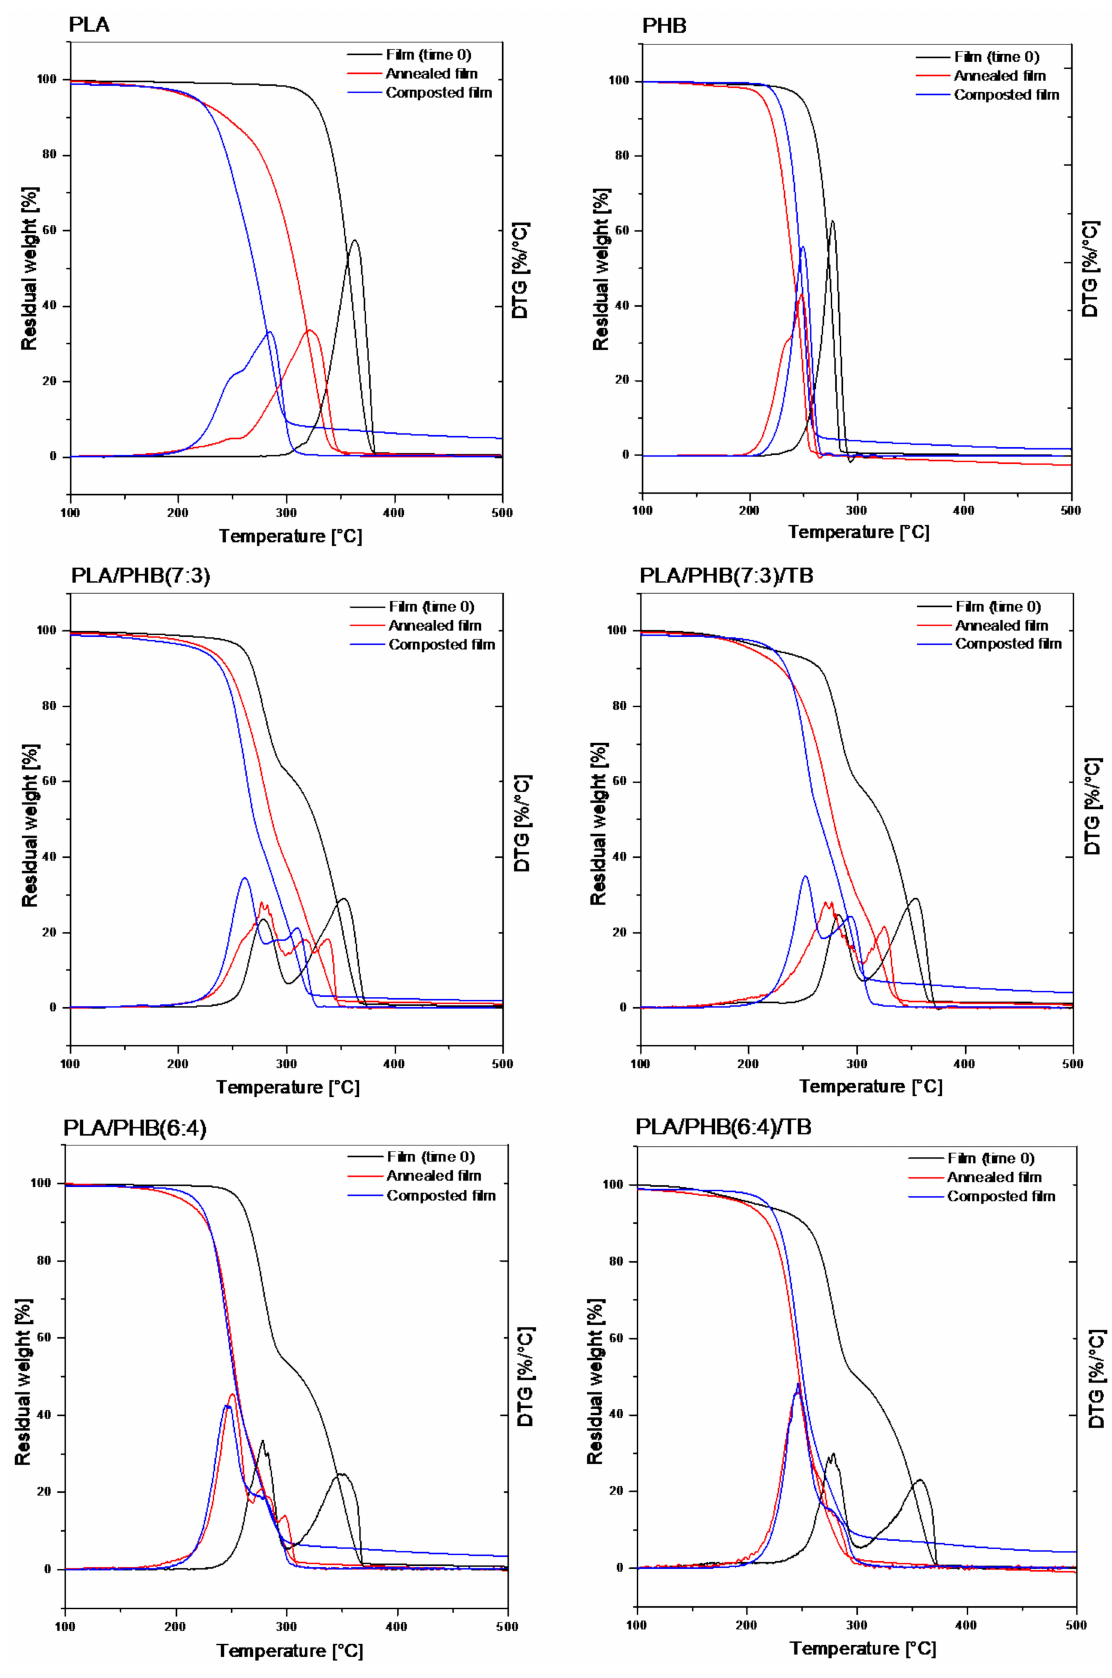
Figure 7. TG and DTG traces of PLA, PHB, PLA/PHB(7:3), PLA/PHB(7:3)/TB, PLA/PHB(6:4), and PLA/PHB(6:4)/TB samples of neat films (black line) and under annealing (red line) and composting (blue line) conditions after 28 days of